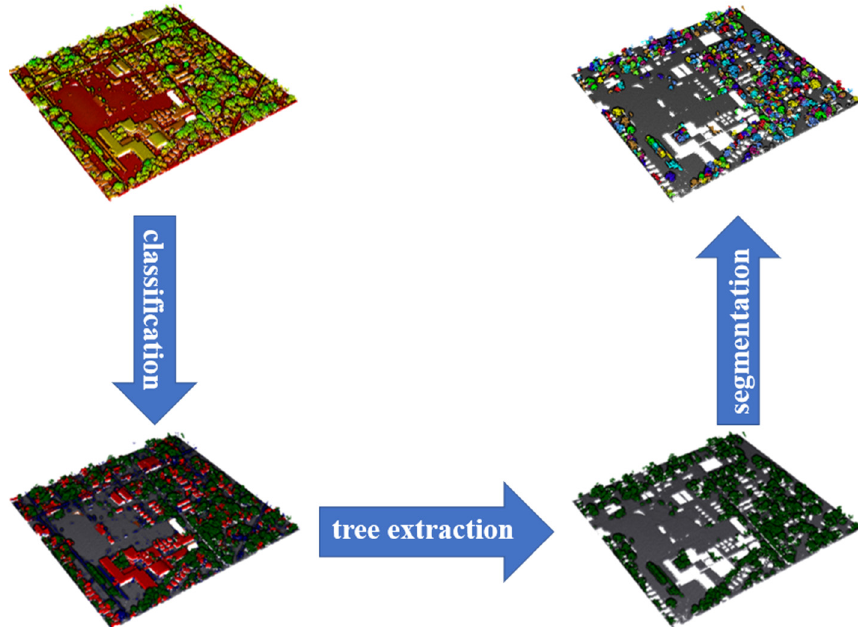
Figure 1. Pipeline of the proposed method.